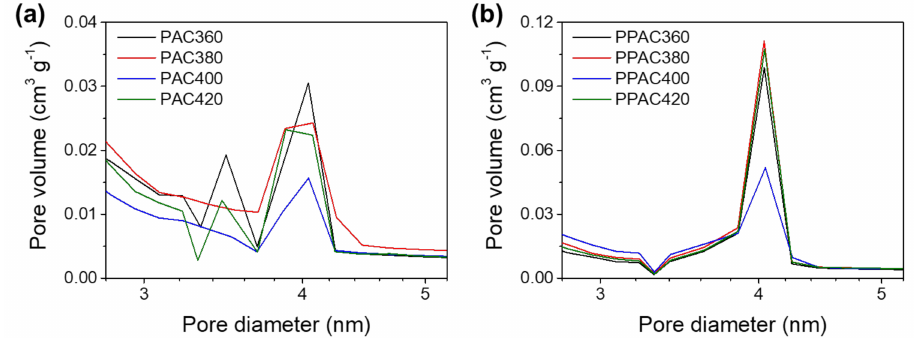
Figure 3. Pore size distribution of ( a ) PAC and ( b )